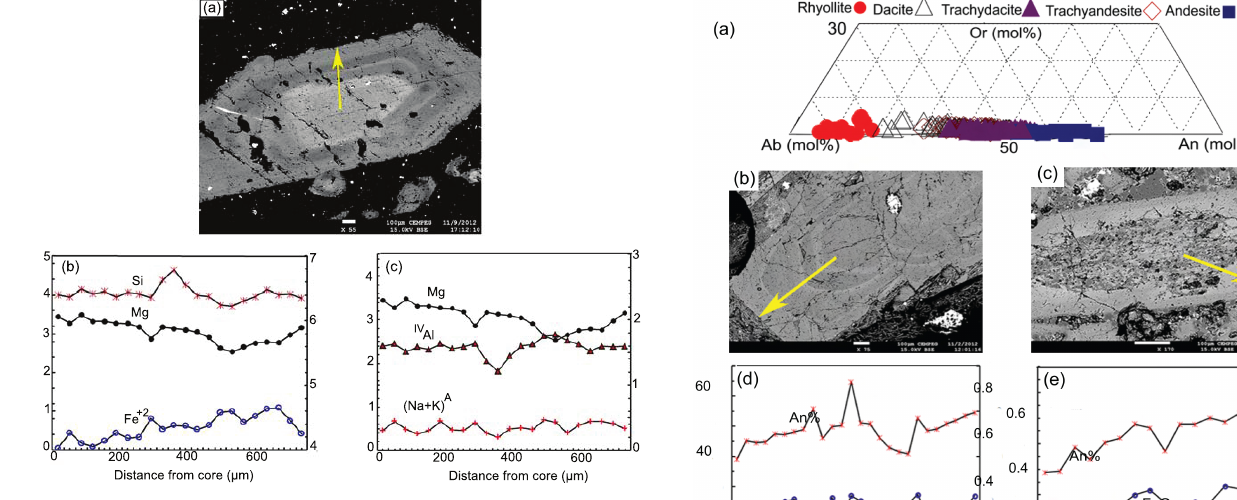
Fig. 10 Figure 10. (a) Back-scatter electron microprobe image of a rep- resentative amphibole phenocryst from a trachydacite sample that comprises distinct alternating dark and light zones. (b) and (c) Ma- jor element traverses in multiple-zoned amphibole phenocryst from (a) . Arrow indicates position of rim to core traverse. Scale bars rep- resent 100µm. Figure 11. (a) Composition of all analyzed plagioclase data points